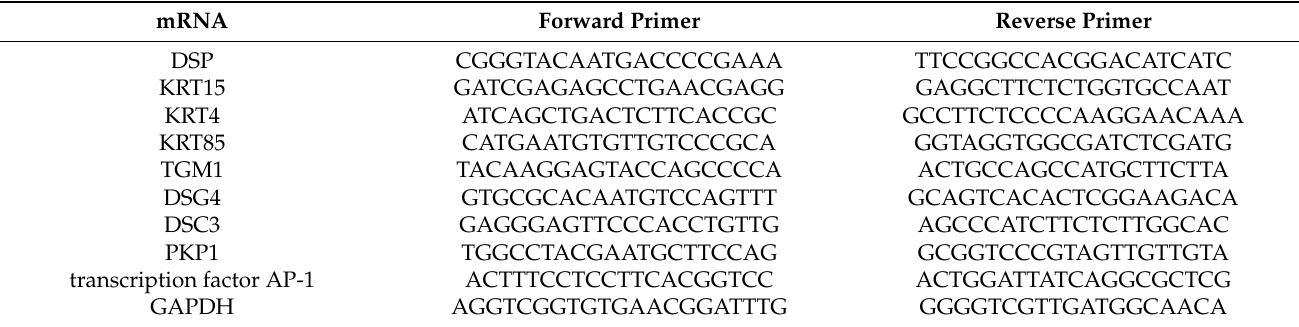
Table 1. Primers for the target